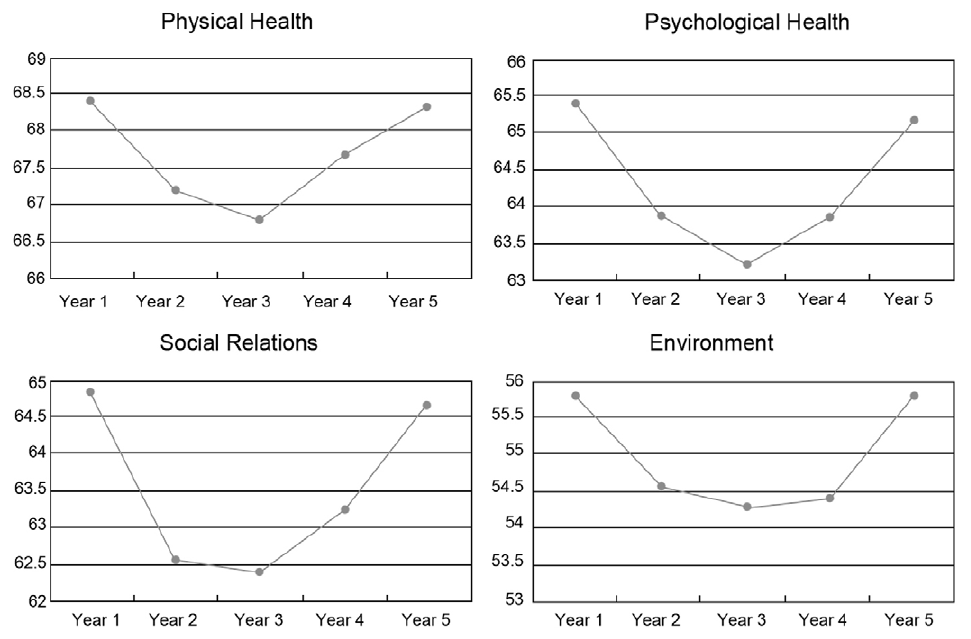
Figure 1. Scores of each domain for medical students. doi:10.1371/journal.pone.0049714.g001 PLOS ONE |